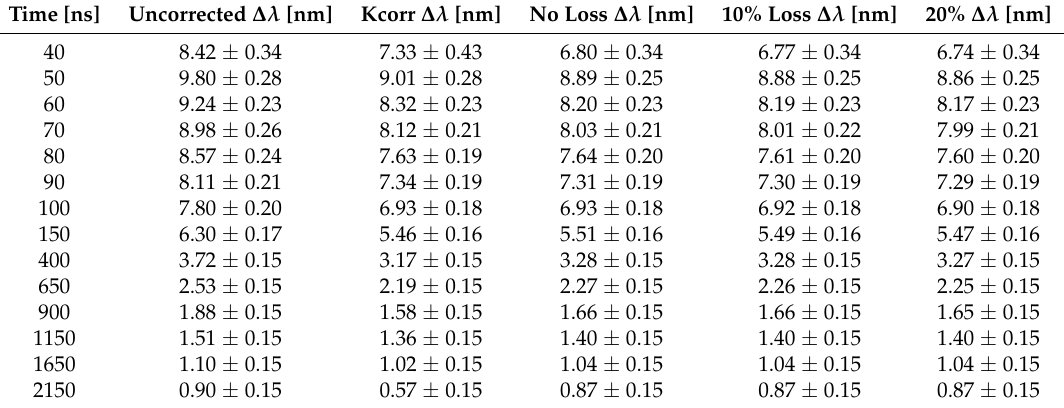
Table 1. Line widths of the H α line prior to and after self-absorption correction using all the stated methods. The 30 ns time delay is excluded form the table because the H α has not yet emerged from the continuum at this